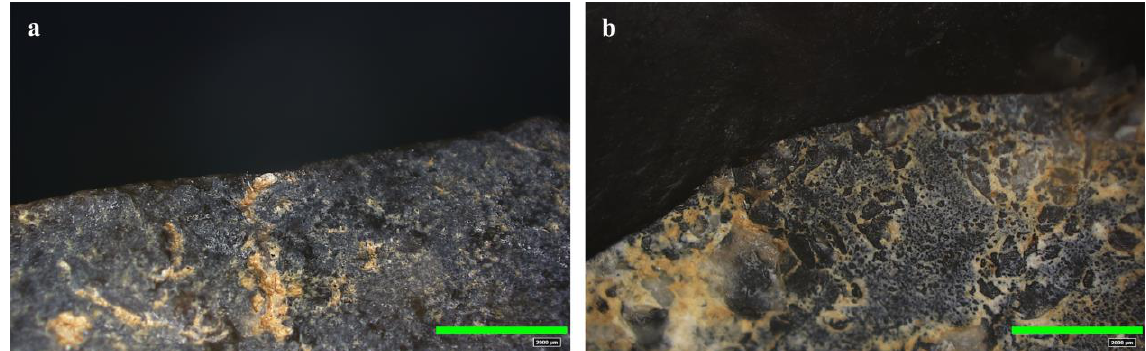
Figure 14. Different types of the cortex from trench B - neo cortex, represented with blue-orange-white film a) sample 34, blade; b) sample 32, flake, scale bar equal to 2000